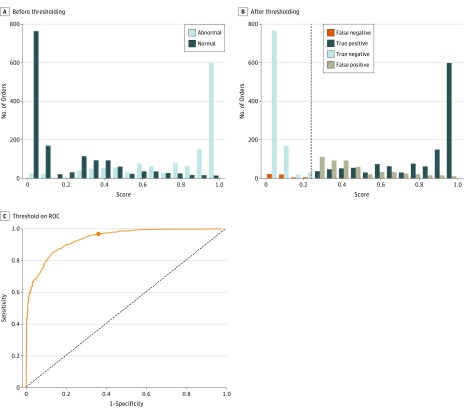
Normality Scores, Decision Threshold, and Receiver Operating Characteristic (ROC) CurveA, Histogram of normality scores distributed among normal and abnormal orders. B, After picking a threshold, orders were classified as predicted to be normal if their normality scores were above the threshold or predicted to be abnormal if they were below the threshold. True-negative orders were predicted to be normal but actually were normal, false-negative orders were predicted to be normal but actually were abnormal, false-positive orders were predicted to be abnormal but actually were normal, and true-positive orders were predicted to be abnormal but actually were abnormal. C, This choice of threshold led to a sensitivity of 96% and specificity of 67%, as shown on the ROC curve.